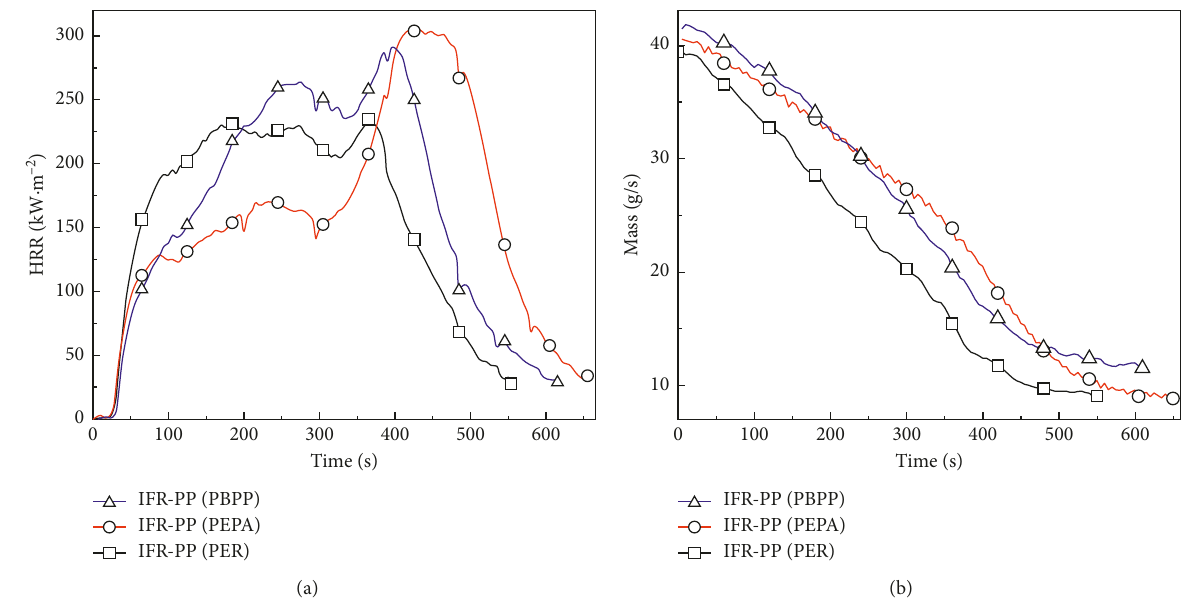
Figure 9: The HRR (a) and mass (b) curves of IFR-PP (PER), IFR-PP (PEPA), and IFR-PP (PBPP).